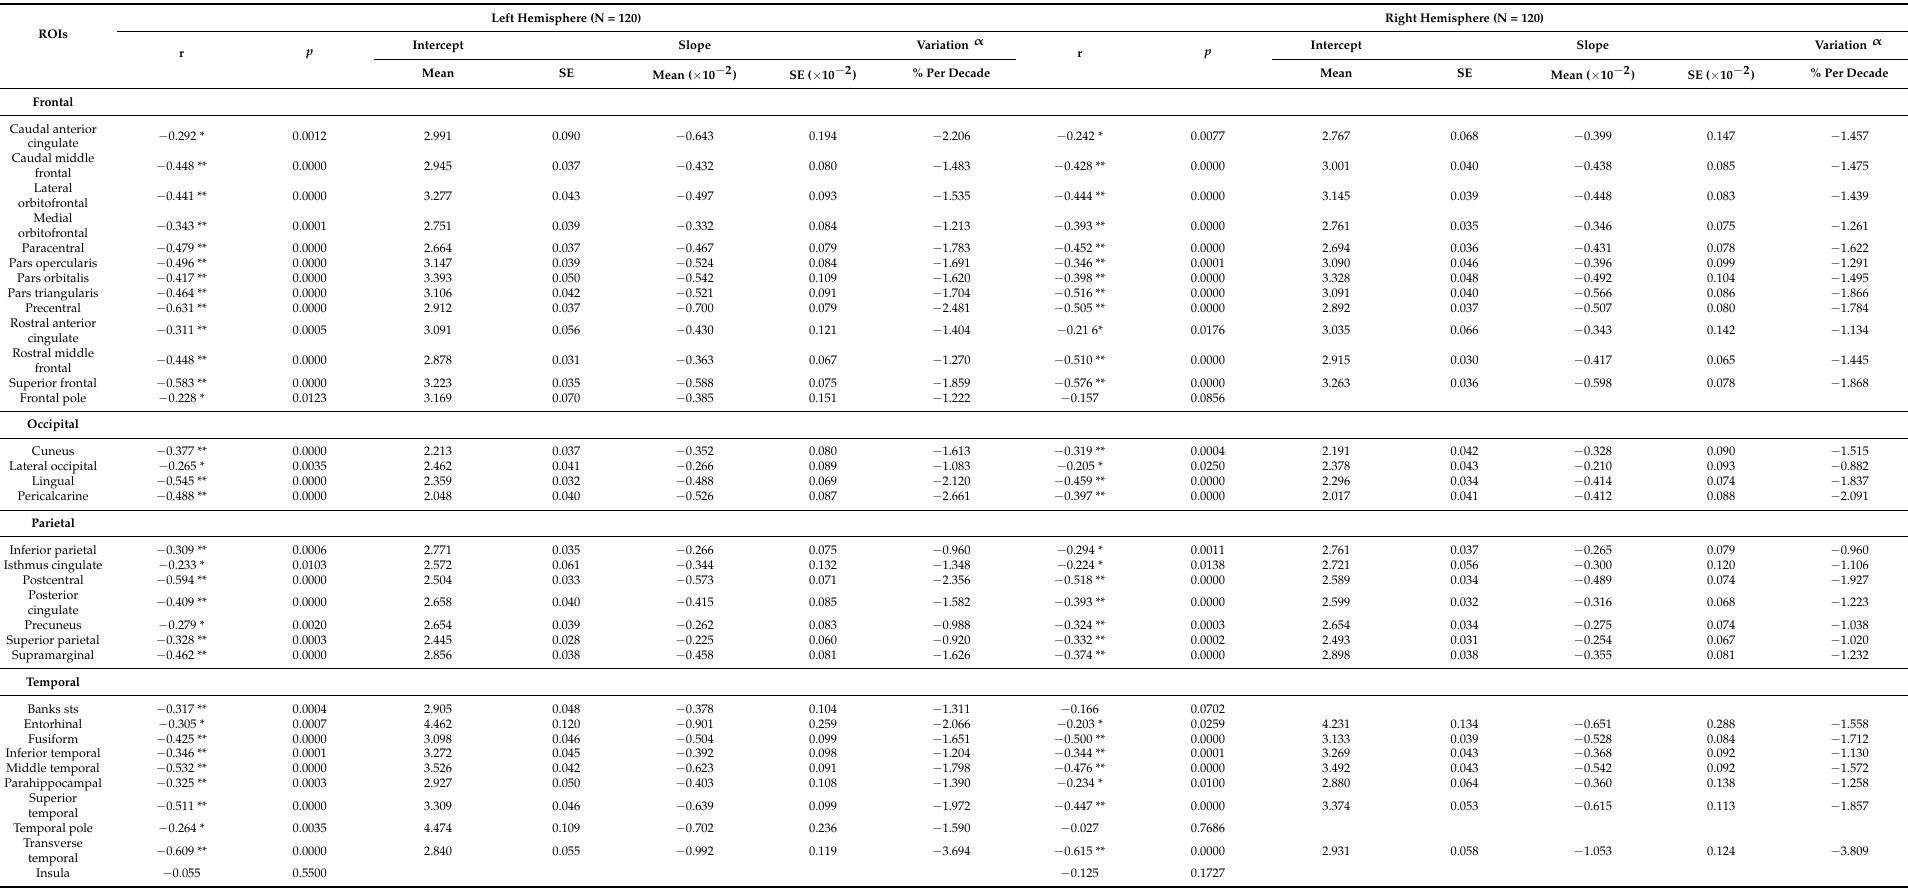
Table 1. Results of linear regression analyses of regional cortical thickness (rCTh) values by age in healthy